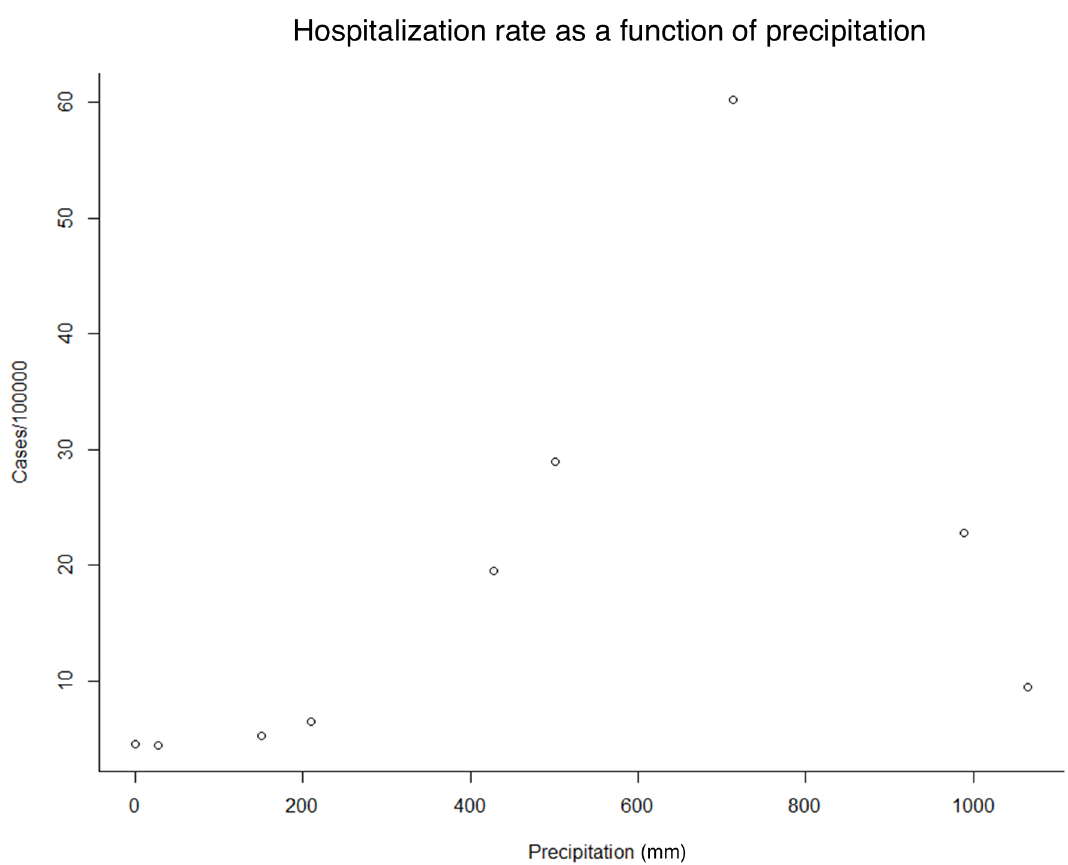
Fig 2. Predicted incidence as a function of precipitation (mm/year). When dividingprecipitation into three categories (0 (cid:20) to < 200, 200 (cid:20) to < 800, and 800 (cid:20) ), the HRR was calculatedas follows, using the lowest category as reference. Precipitation200 (cid:20) to < 800 mm/year: 1.60 [0.69,3.81] p-value = 0.21. Precipitation800 (cid:20) mm/year: 1.35 [0.51, 3.69] p- value = 0.52